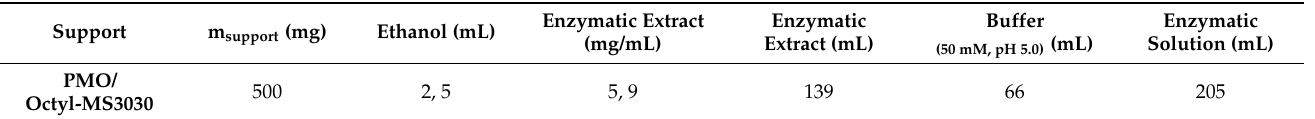
Table 3. Required amounts to obtain the desired enzyme load (400 mg lipase/g support) in both supports, PMO or